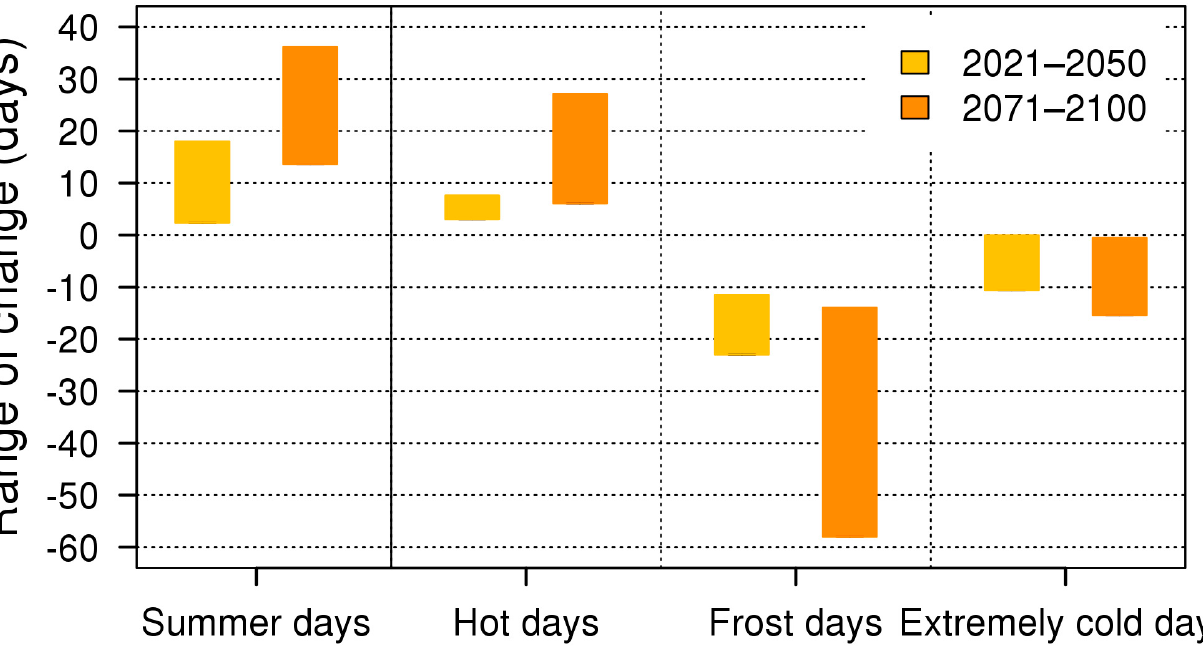
Figure 11. Range of the minimum and maximum changes (in days) in the mean annual number of summer days, hot days, frost days and extremely cold days over Hungary for 2021–2050 and 2071–2100 based on four RCM simulations. Reference period: 1971–2000.